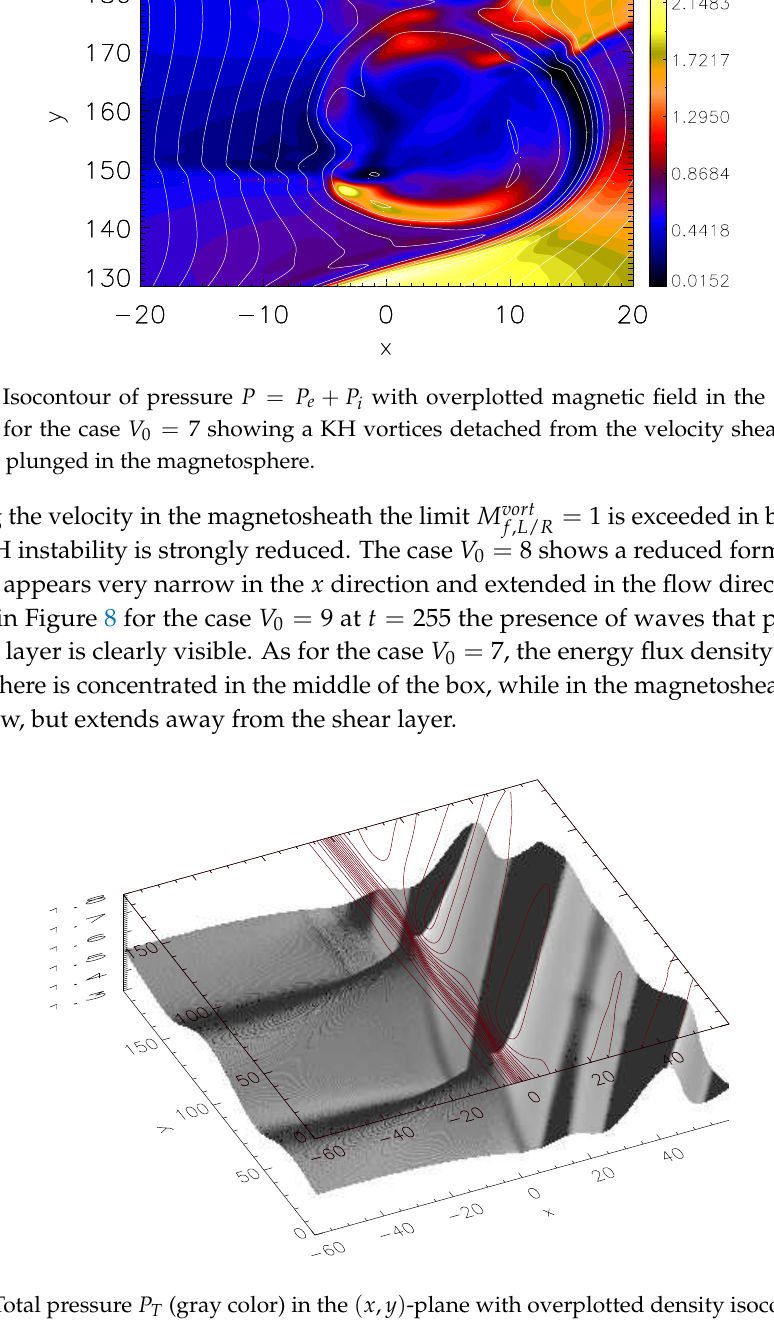
Figure 8. Total pressure P T (gray color) in the ( x , y ) -plane with overplotted density isocontour lines (red color) at t = 255 for the case V 0 = 9. The density isocontour puts in evidence that not vortex structures are generated in the middle of the box, but only perturbations emphasized on the pressure quantity via the emission of fast waves from the shear layer.